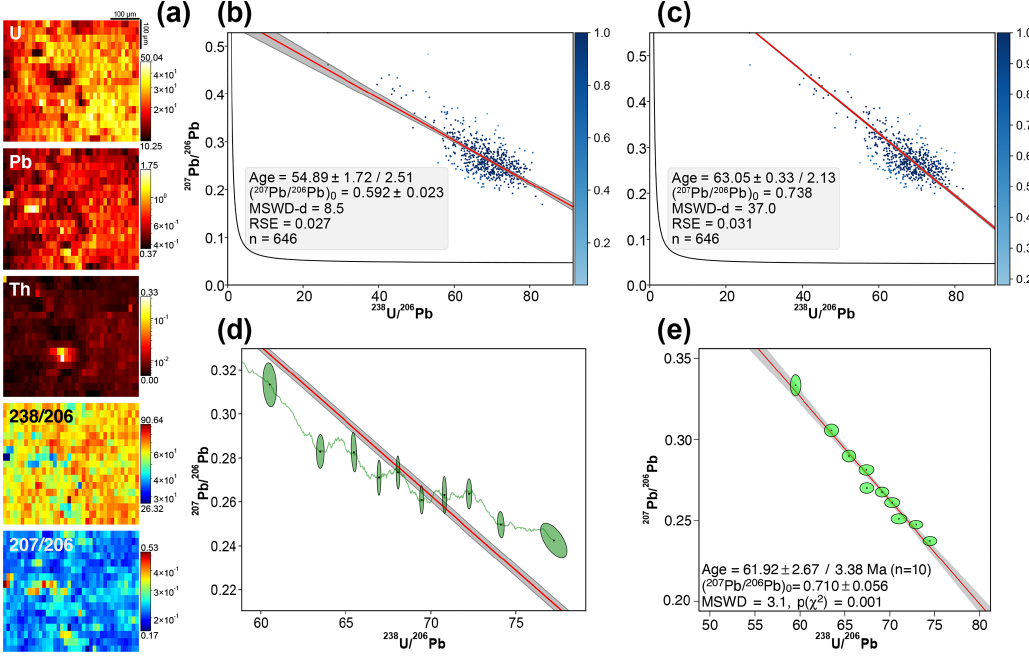
Figure 2. (a) Element concentrations in parts per million (U, Pb and Th) and 238 U / 206 Pb– 207 Pb / 206 Pb isotopic maps obtained for one analysis of Duff Brown sample. Note that the concentrations are normalised to the mean number of counts measured in the NIST reference material for the considered masses and should, thus, be regarded only as semi-quantitative. (b) TW concordia plot with age calculated by robust regression, without anchoring the common Pb value (( 207 Pb / 206 Pb) 0 ). The age uncertainties (1.96 σ level) are without (left) and with (right) uncertainty propagation. The blue colour scale refers to the weight attributed to each pixel by the robust regression. Panel (c) is the same as panel (b) but with common Pb anchored to a value of 0.738 as calculated from Hill et al. (2016). (d) TW concordia plot with ellipses calculated from the sets obtained by the discretisation of the pixel ratio values used for regression and those used for the calculation of the MSWD-d (see text for details). The regression and associated confidence interval are those obtained by the robust regression. In this example, the ( 207 Pb / 206 Pb) 0 value is anchored. (e) TW concordia plot of the same sample obtained with the method of Drost et al. (2018), without anchoring the common Pb value. The age and associated uncertainties were obtained from York-type regression using IsoplotR; age uncertainties (1.96 σ level) are without (left) and with (right) systematic